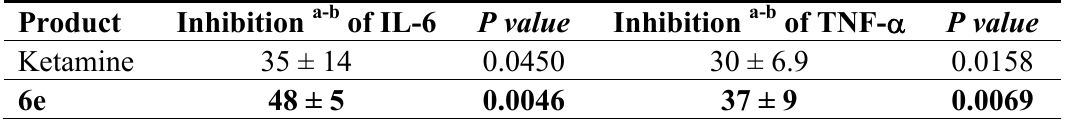
Table 4. Inhibitory effect of compound 6e on IL-6 and TNF- α secretion in an animal model of sepsis. Compound was injected at 10 mg/kg prior to sepsis (See experimental section for